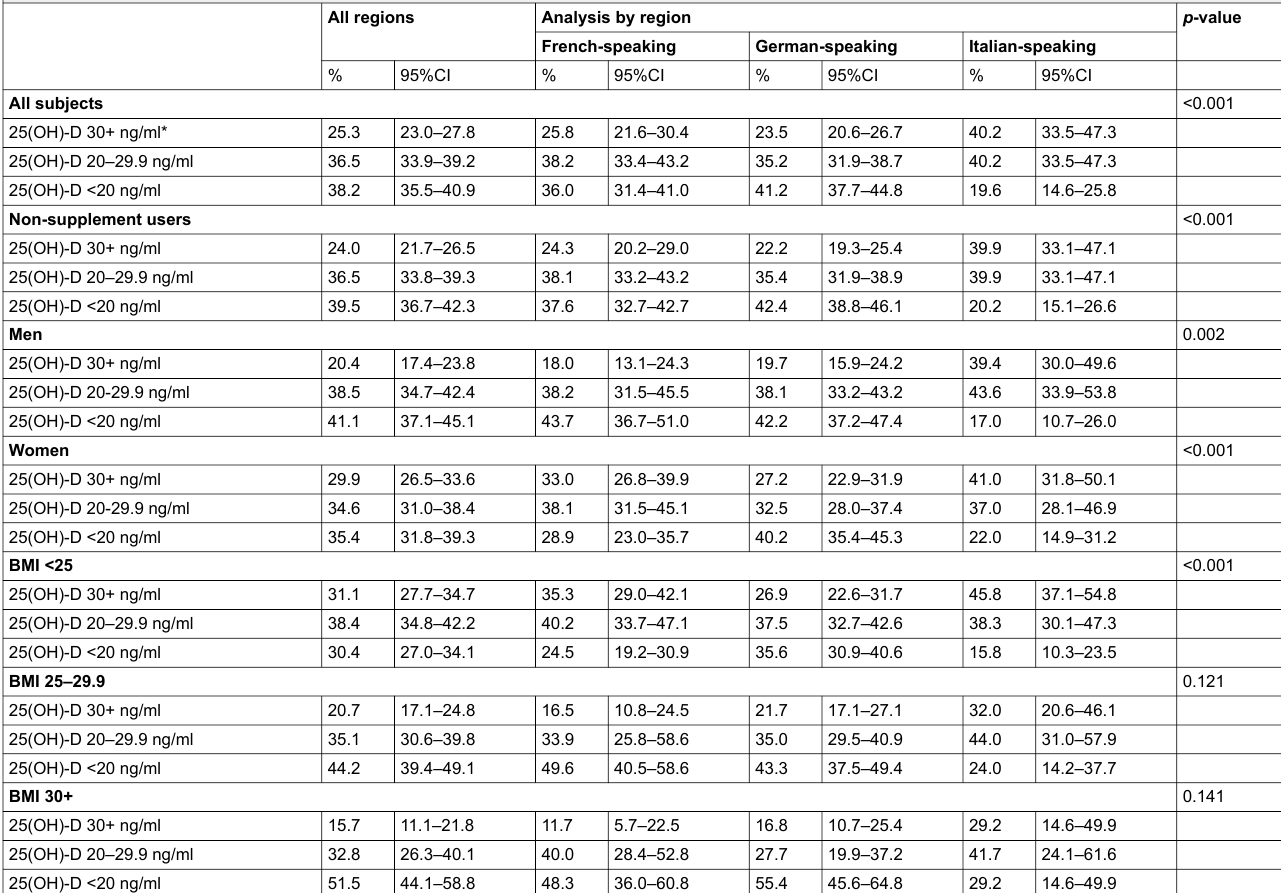
Table 3: Prevalence of vitamin D sufficiency (30+ ng/ml), insufficiency (20‒29.9 ng/ml), and deficiency (<20 ng/ml)*, by characteristics and region.